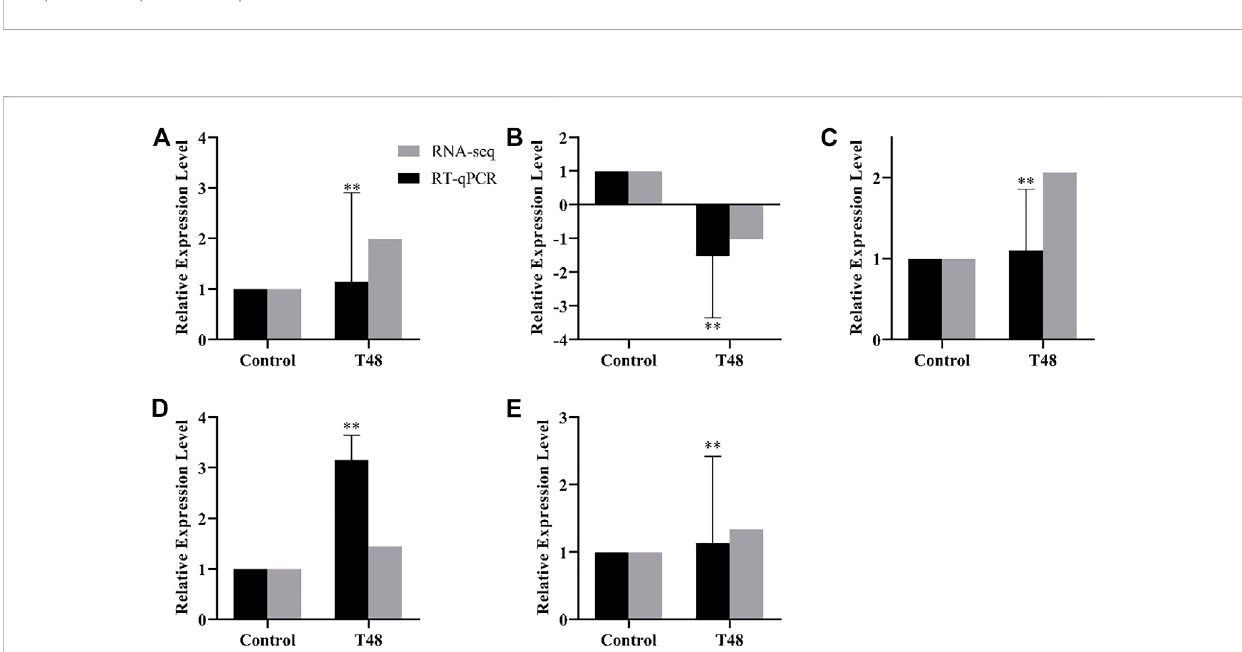
FIGURE 8 Control vs. T48. RT-qPCR results of RNA-Seq sequencing data of differentially expression genes (DEGs). Data in the fi gure are mean ± SD, and the asterisk above bars represents extremely signi fi cant difference between the treatment group and the control group of the gene relative expression level (* p < 0.05; ** p < 0.01; unpaired t -test). (A) : Mblk-1 , (B) : l(2)e fl , (C) : FoxP , (D) : FoxO , (E) :